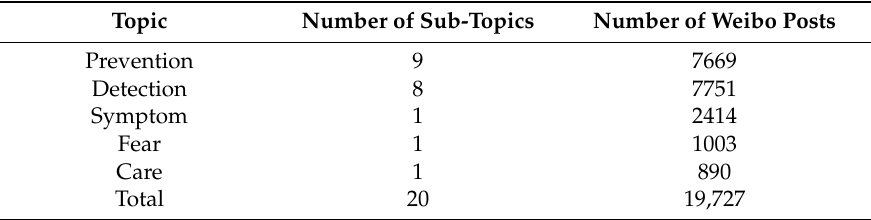
Table 3. Distribution of